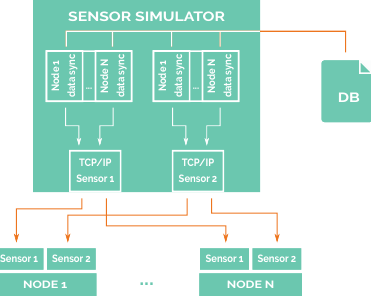
Figure 5. Sensor simulator